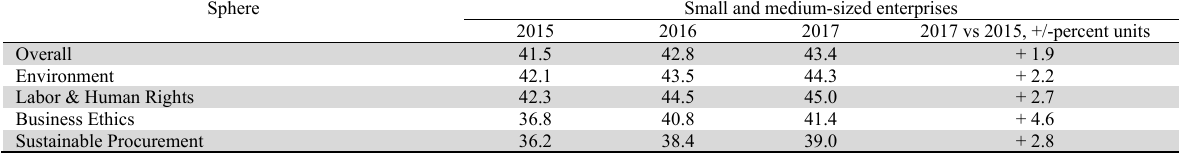
Sphere Small and medium-sized enterprises 2015